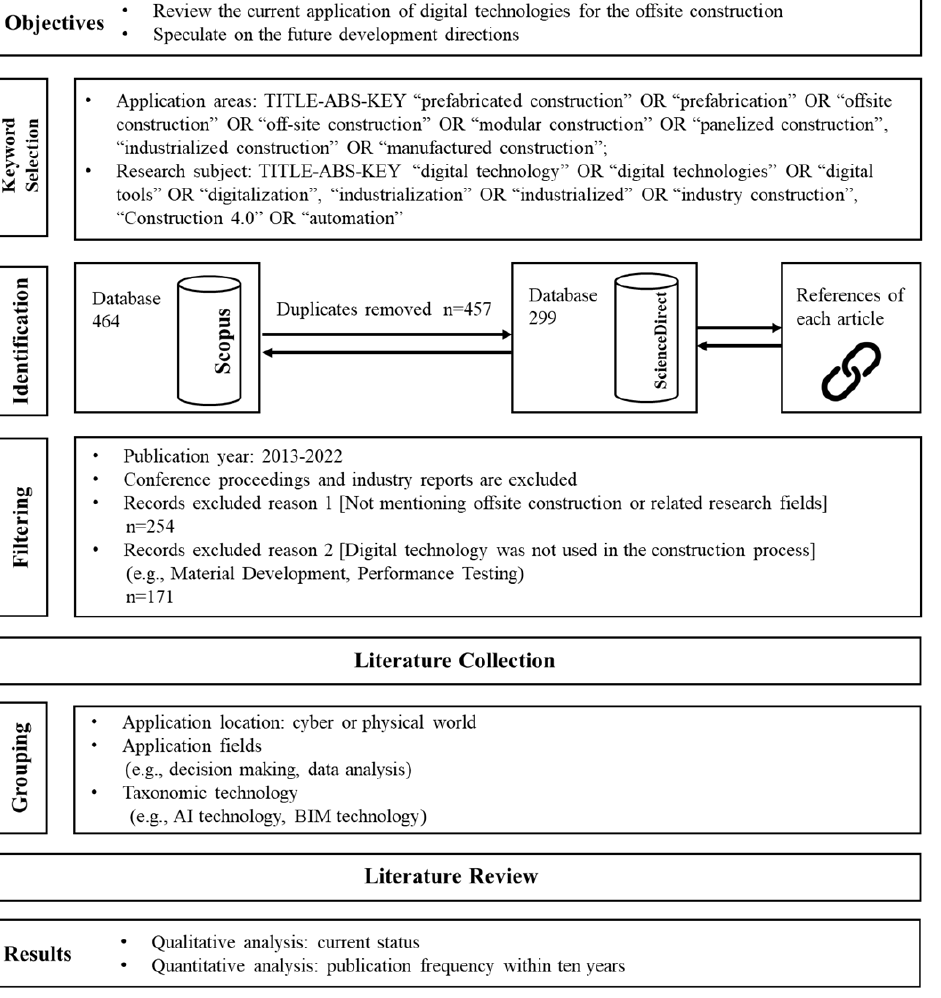
Figure 2. Research method